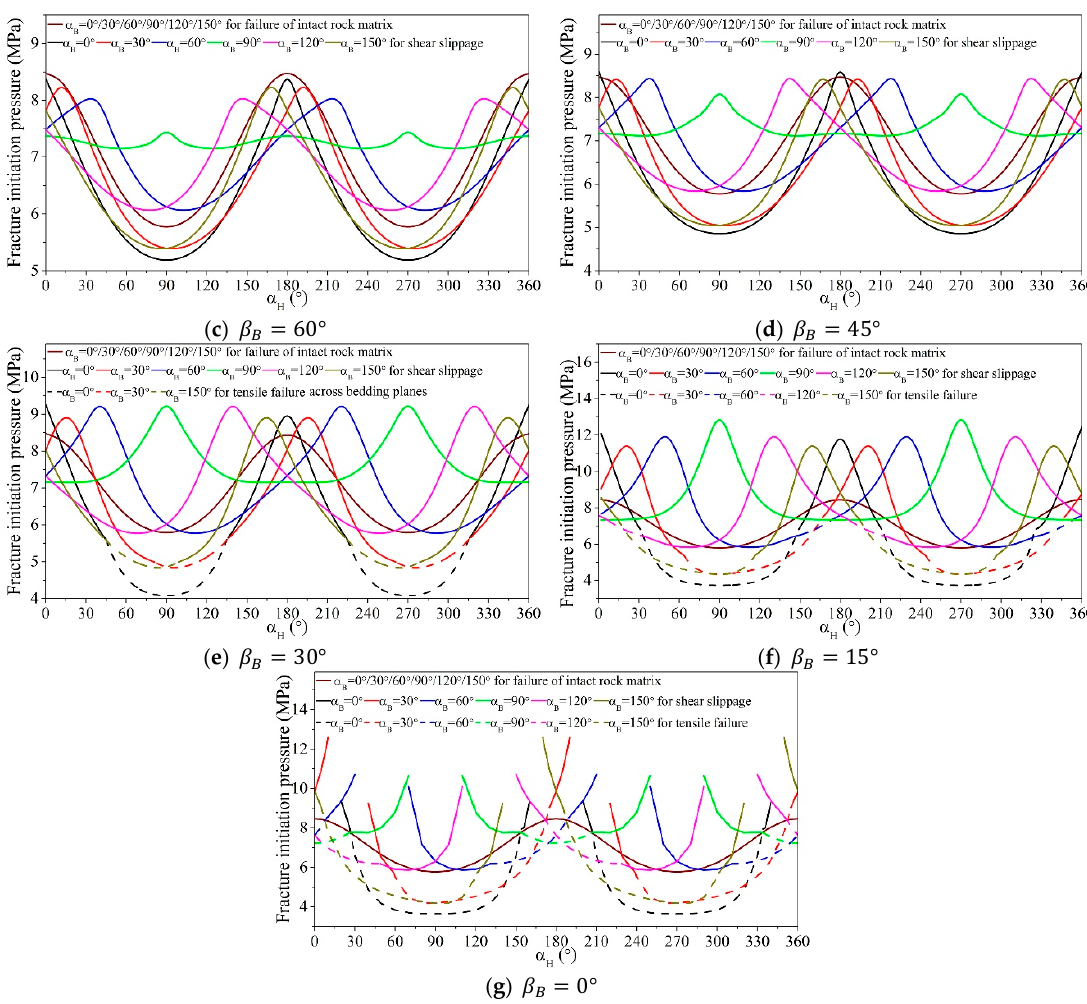
Figure 10. Variation in fracture initiation pressure of Nong’an oil shale with drilling direction for di ff erent bedding planes for the dip angle of ( a ) 0 ◦ , ( b ) 15 ◦ , ( c ) 30 ◦ , ( d ) 45 ◦ , ( e ) 60 ◦ , ( f ) 75 ◦ , ( g ) 90 ◦ . The wine solid line represents failure of the intact rock matrix. The two di ff erent line styles (solid and dashed lines) with di ff erent colors (black, red, blue, green, magenta and dark yellow) represent shear slippage along the bedding planes and tensile failure across the bedding planes with α B = 0 ◦ , α B = 30 ◦ , α B = 60 ◦ , α B = 90 ◦ , α B = 120 ◦ and α B = 150 ◦ , respectively. Besides, the color cyan represents